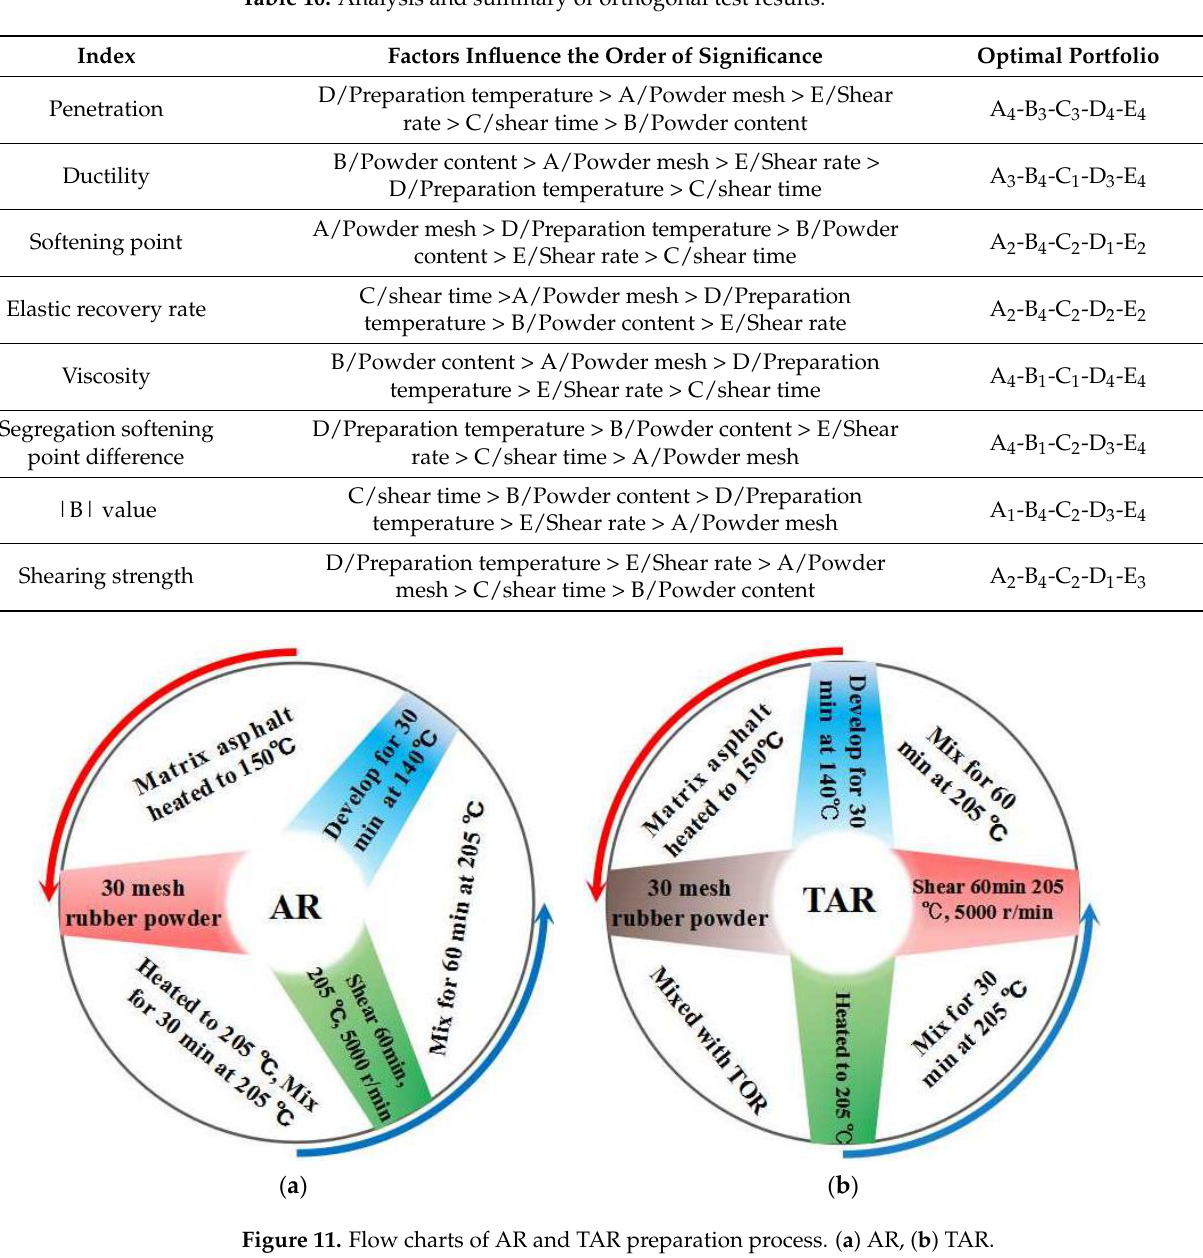
Table 10. Analysis and summary of orthogonal test results.